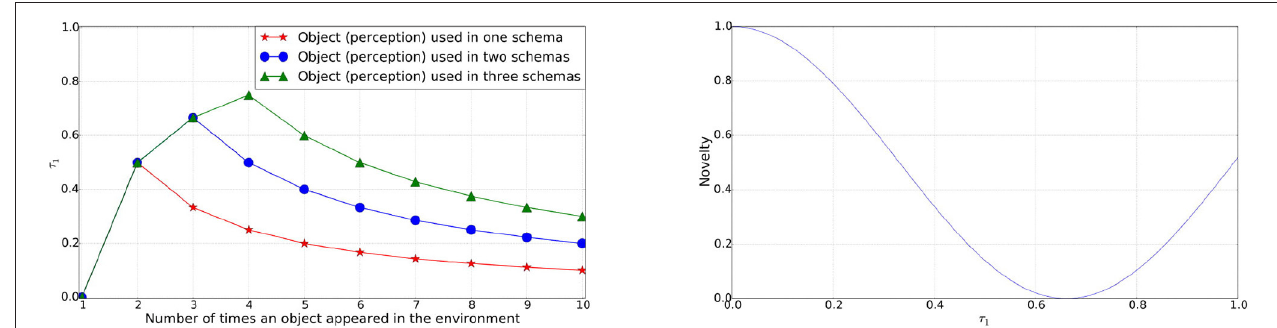
FIGURE 1 | Left : Value of τ 1 for an object perception used in 1, 2, or 3 schemas continuously against the number of times it appeared in the environment. Right : Novelty of an object perception over the range of value for τ 1 .